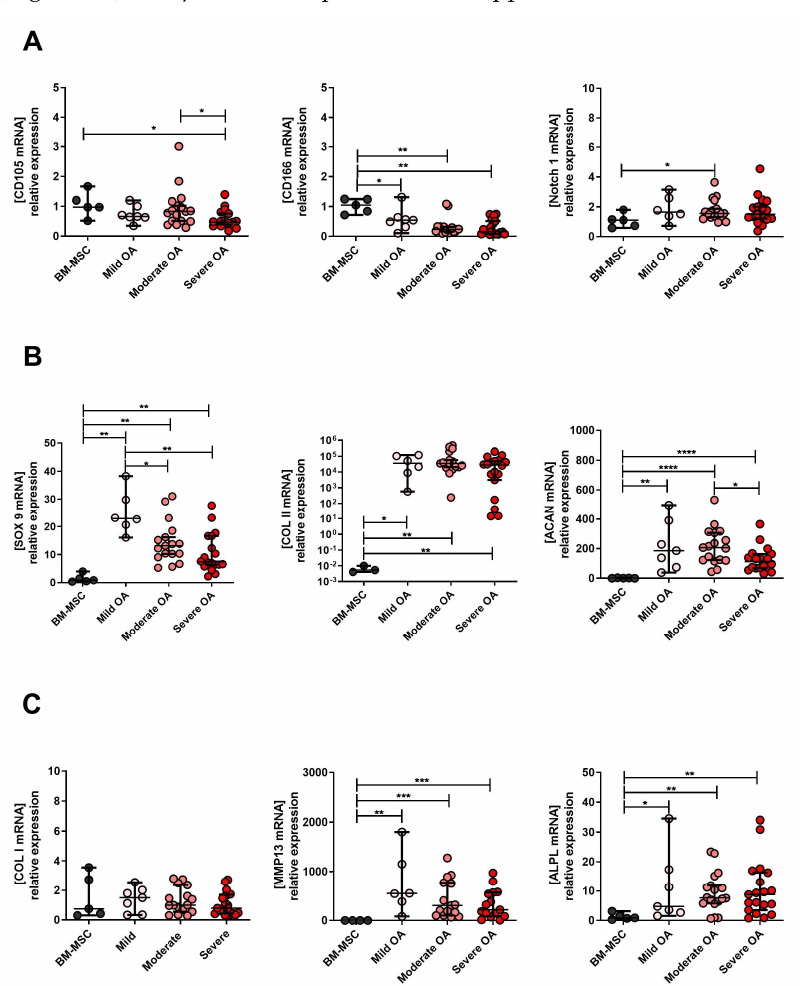
Figure 4. The mRNA expression of MPC, chondrocyte and hypertrophic chondrocyte markers in mild, moderate and severe OA-derived cells compared to BM-MSC. ( A ) mRNA expression levels of CD105, CD166 and Notch 1 (MPC markers) in BM-MSC cell line and mild, moderate and severe OA-derived cells expanded in vitro for 2 weeks (D14). ( B ) mRNA expression levels of Sox9 (MPC marker), Acan, Col II (chondrocytes markers) in mild, moderate and severe OA-derived cells ex- panded for 2 weeks in vitro (D14) and BM-MSC cell line. ( C ) The mRNA expression levels of Col